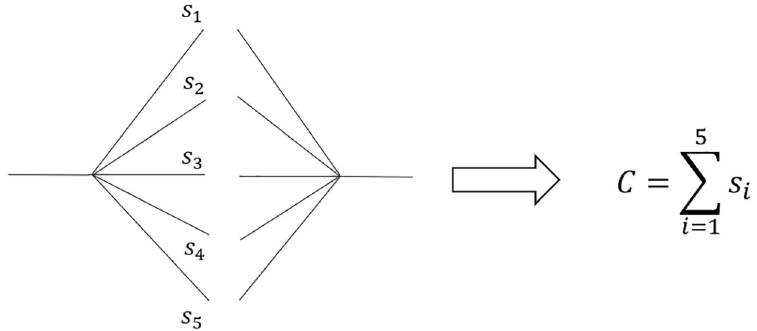
Fig 2. The summation of weights of individual synaptic connections to a conglomerate synapse C